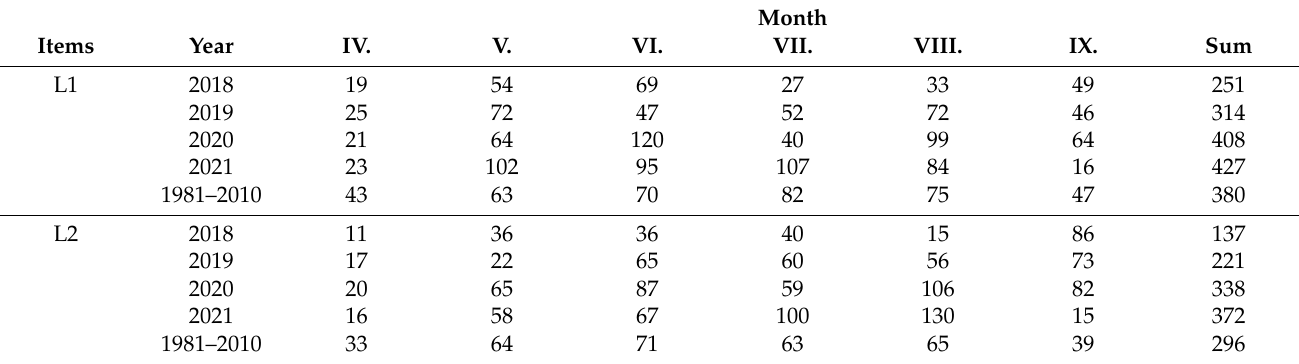
Table 3. Precipitation (mm) in the growing season 2018–2021 (source: CHMI